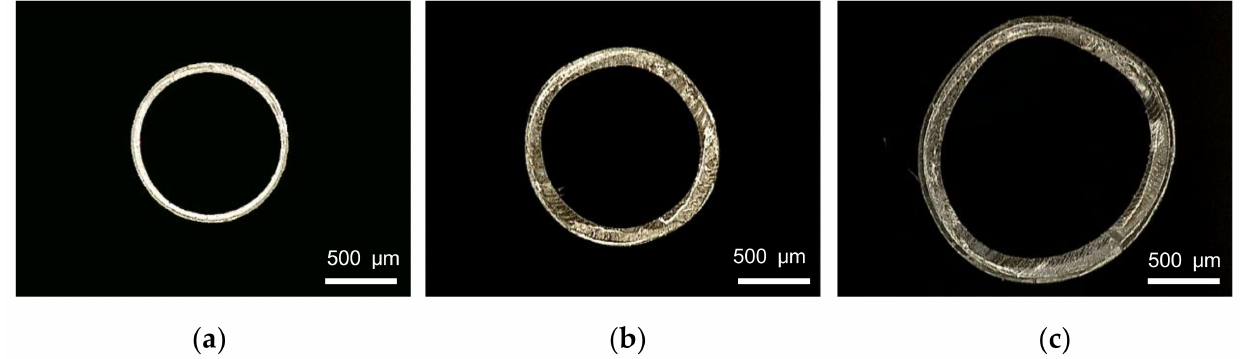
Figure 7. Cross section of micro tubes at different screw speeds: ( a ) Screw speed = 1 r/min; ( b ) Screw speed = 5 r/min; ( c ) Screw speed = 8